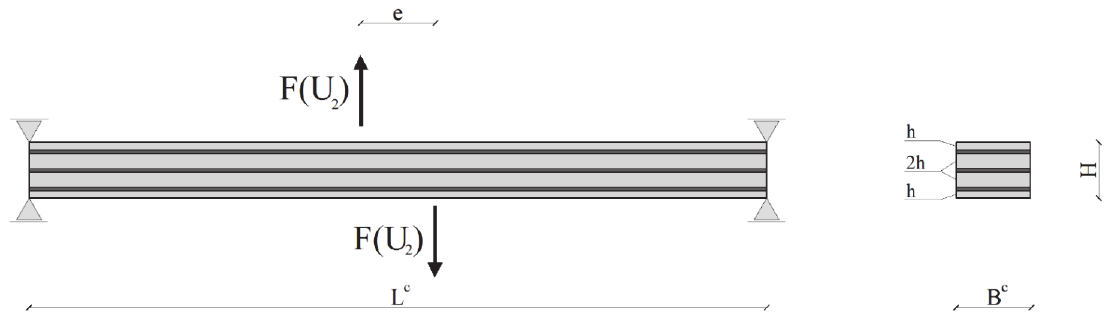
Figure 4: Laminate configuration and loading scheme.